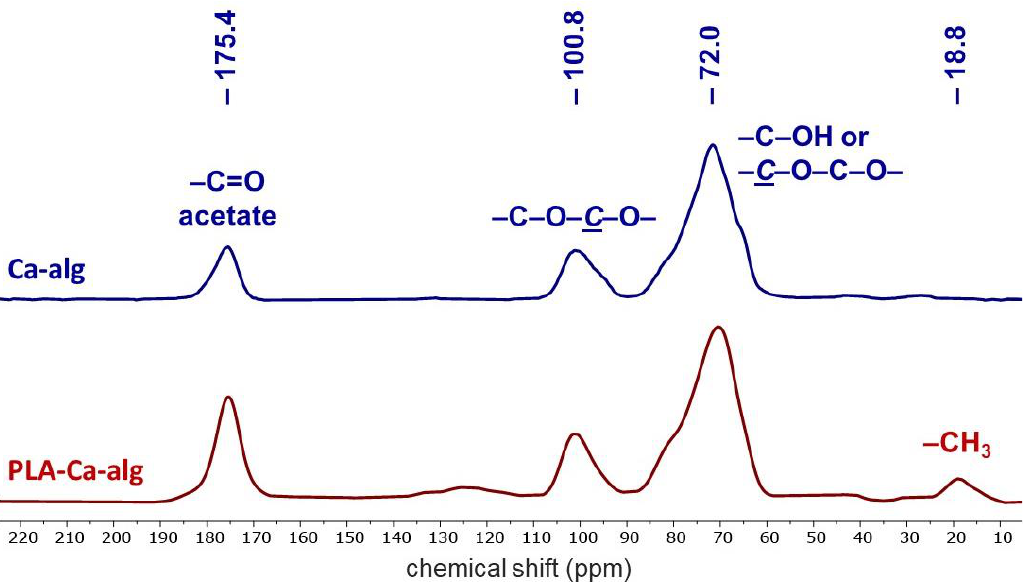
Figure 3. 13 C CPMAS NMR spectra of Ca-alginate and g-Ca-alginate aerogels, as indicated, with annotated characteristic peaks.